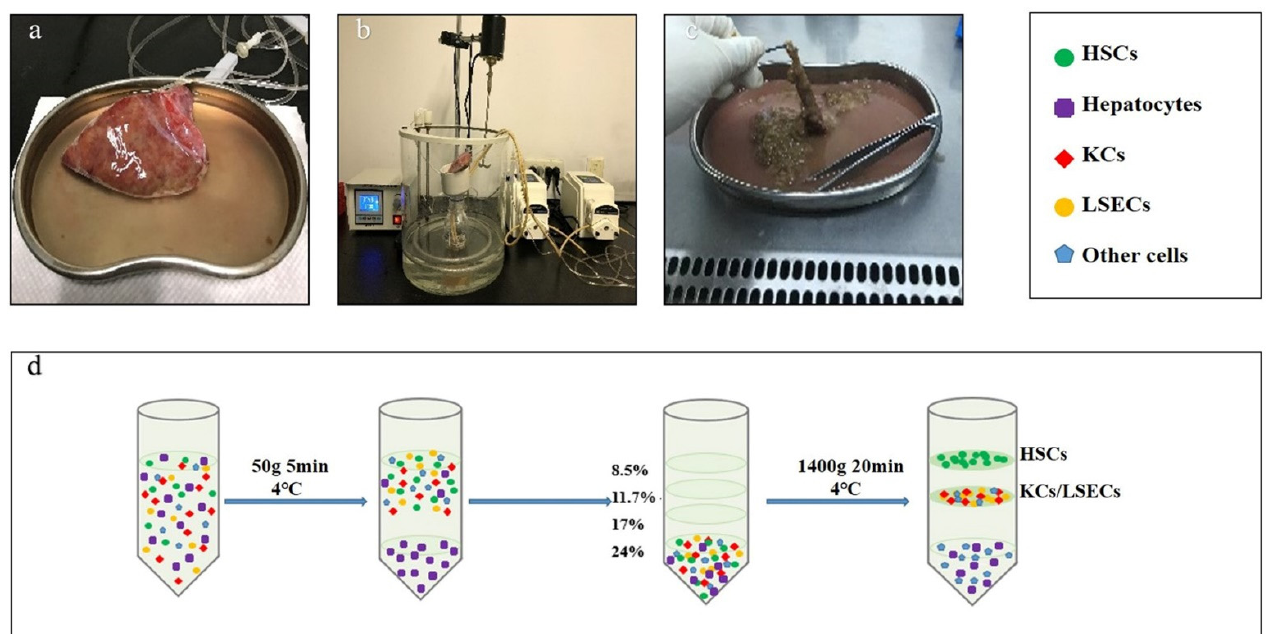
Figure 1. Isolation procedure of human primary HSCs from liver tissue specimens. ( a ) Perfusion catheters were inserted into the larger blood vessels, and the section of liver tissue was closed. ( b ) Liver tissue was digested by recirculating perfusion for 15–25 min using collagenase type IV. ( c ) The digested liver tissue was shredded with tweezers to prepare the cell suspension. ( d ) Hepatocytes were removed by centrifugation (50× g , 5 min, 4 °C, 3 times), and HSCs were isolated by density gradient centrifugation (1400× g , 20 min, 4 °C). Hepatic stellate cells, HSCs; Kupffer cells, KCs; liver sinusoidal endothelial cells, LSECs.